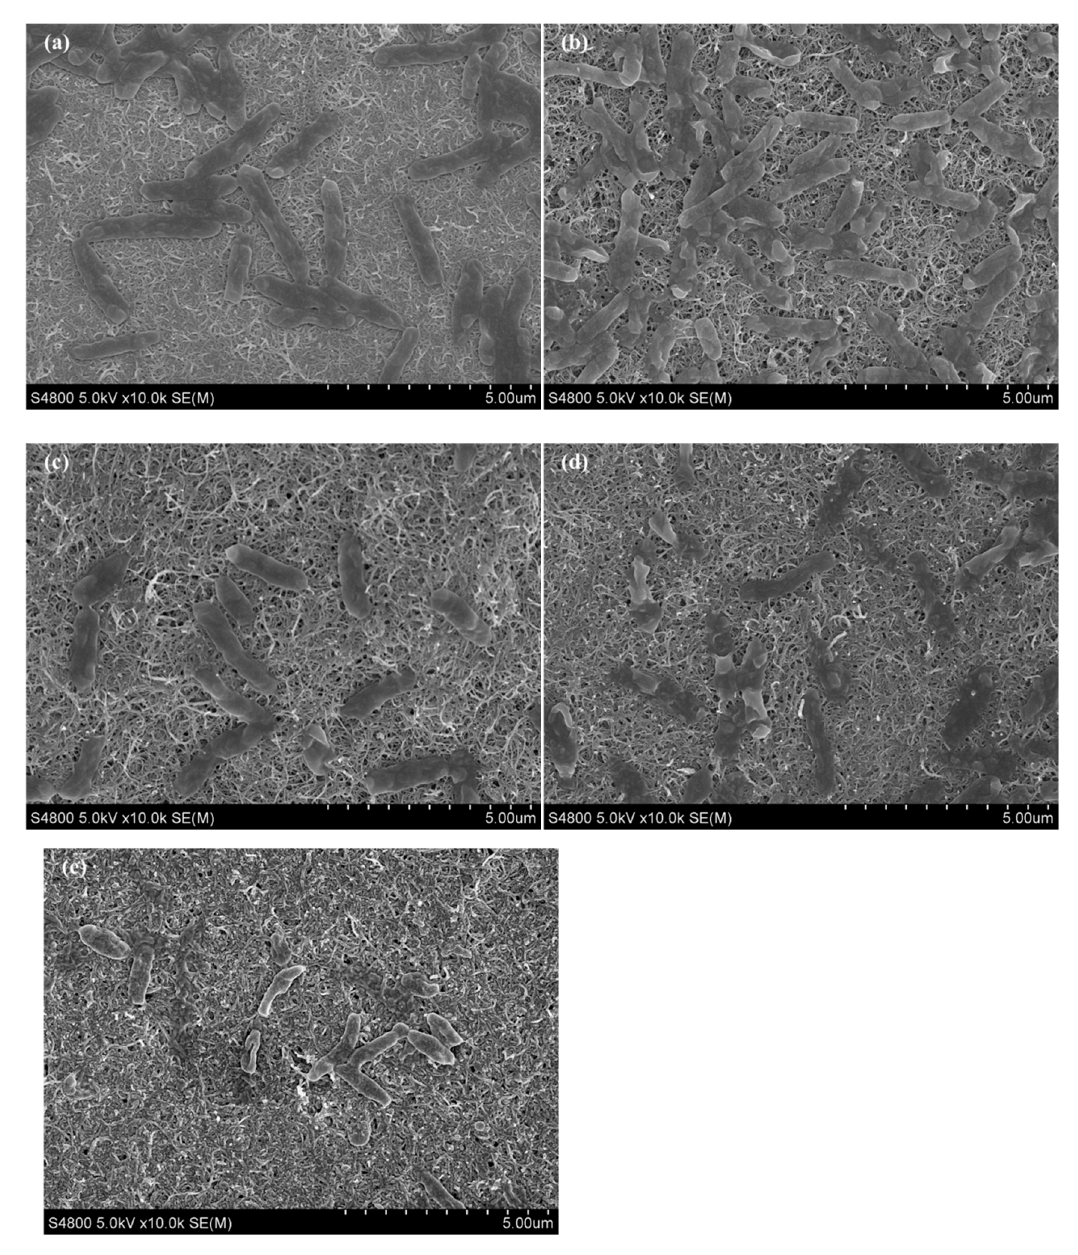
Figure 6. SEM images of (CNTs/PAH) n -deposited ITO electrode after 25 h of chronoamperometry. ( a– e : n = 3, 5, 7, 9, 12).